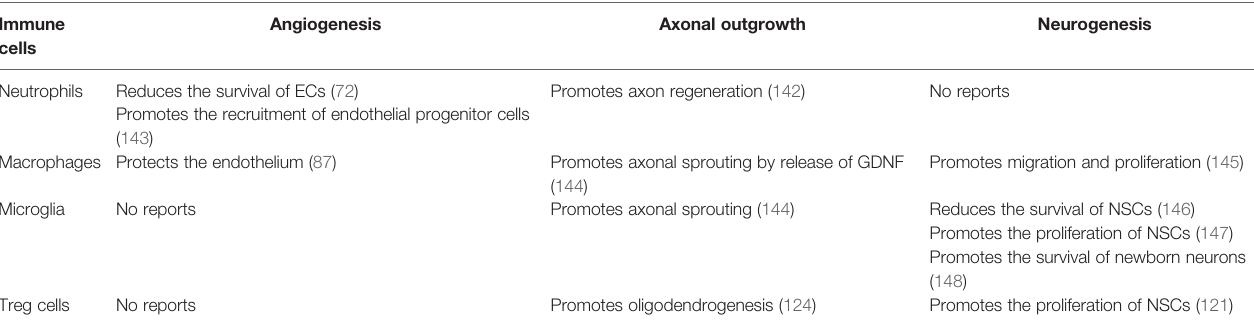
TABLE 3 | The role of various immune cells on angiogenesis, axonal outgrowth and neurogenesis after stroke. Immune cells